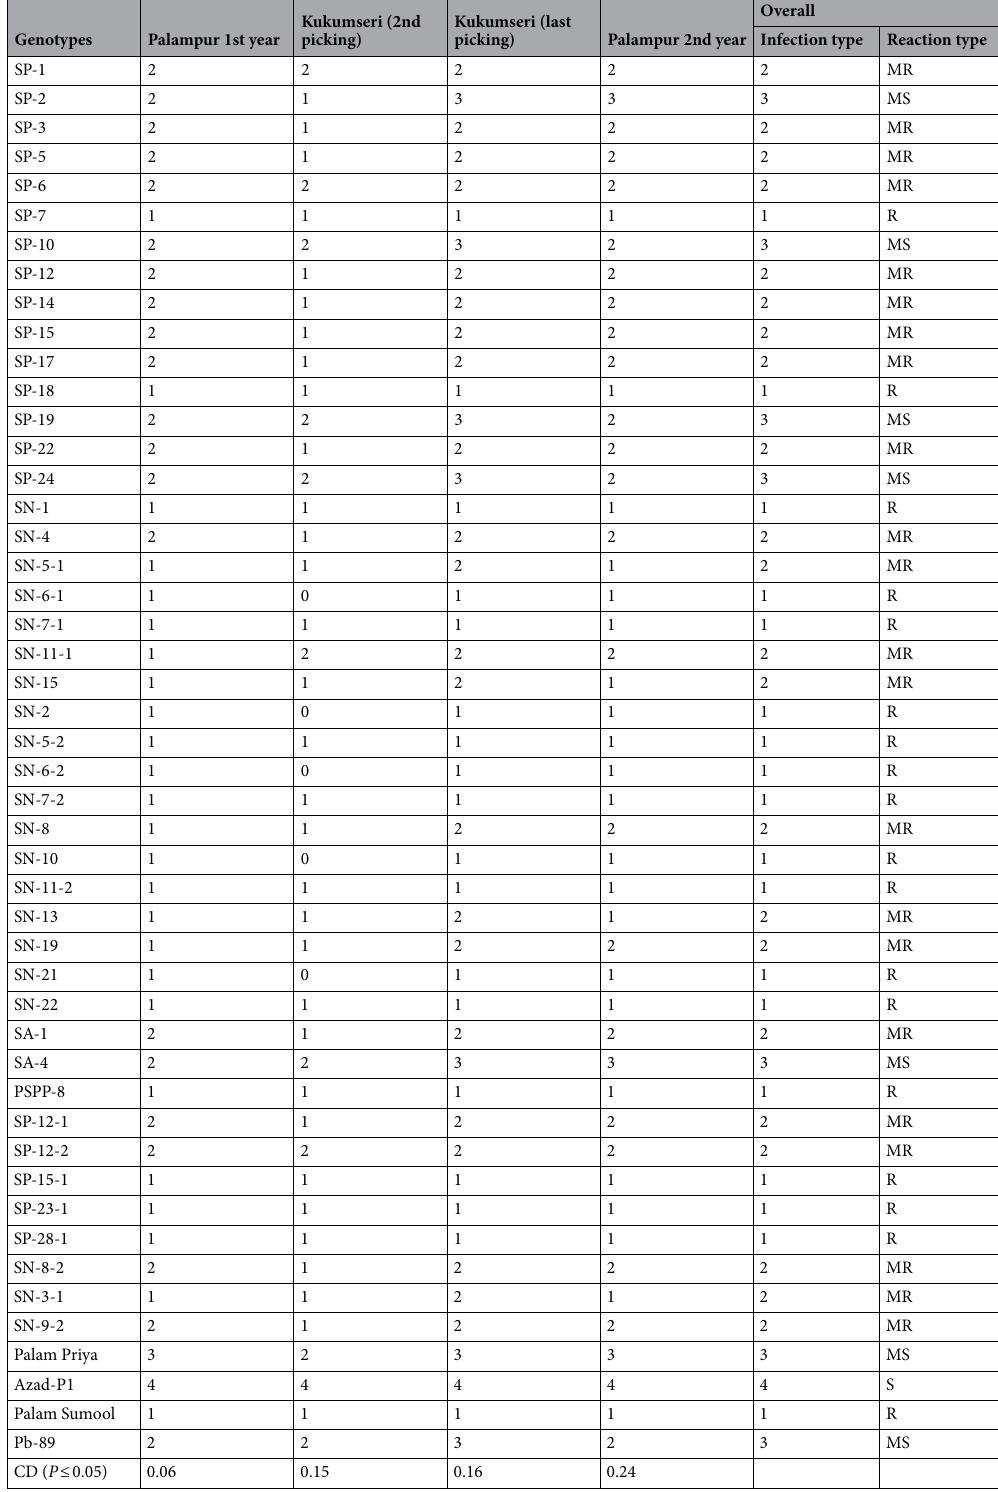
Table 5. Screening of the genotypes for powdery mildew incidence under field conditions. where R Resistant; MR Moderately resistant; MS Moderately susceptible; S